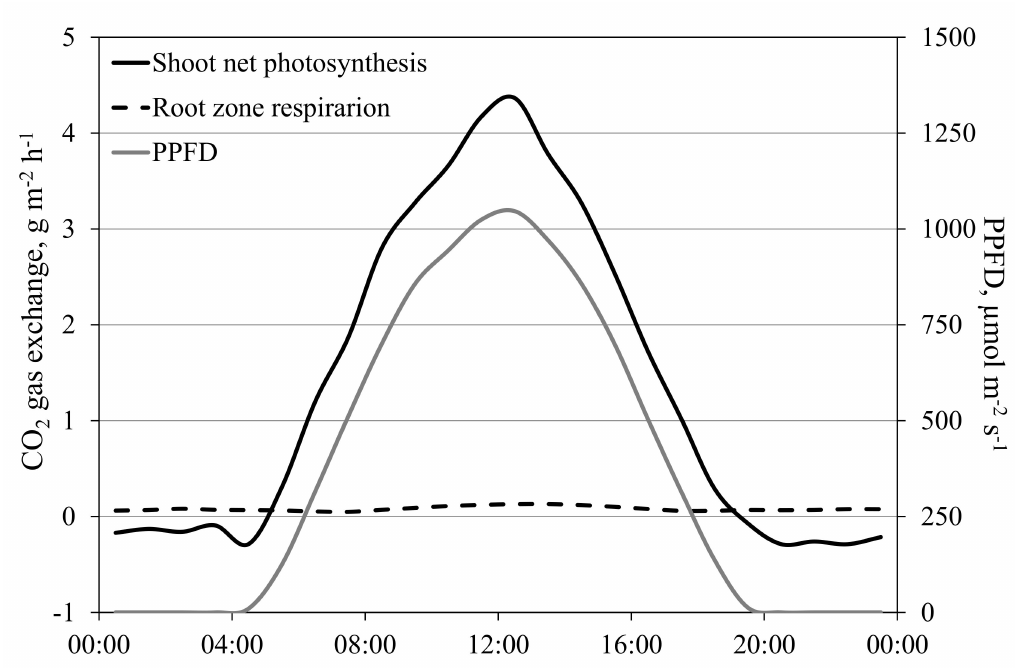
Figure 12. CO 2 gas exchange in the shoot and root zone of a tomato crop on 10 May 2016. Shoot (stem, leaves and fruit) and root dry matter were 615 and 104 g m − 2 , respectively, and leaf area was 2.2 m 2 m − 2 . Temperature in the root environment was kept constant at 19 ◦ C, while cabin temperature rose from 15 ◦ C at night to 30 ◦ C in the middle of the